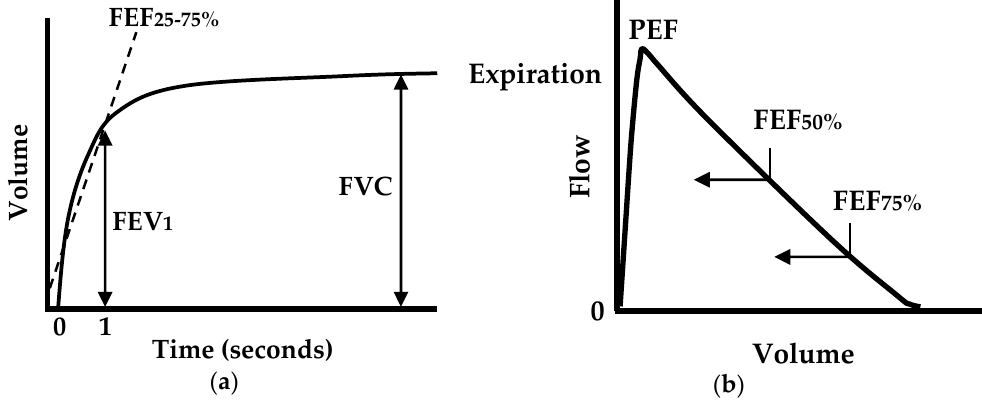
Figure 1. Examples of forced expiratory flow measure, ( a ) volume-time plot; and ( b ) volume–flow plot [7].